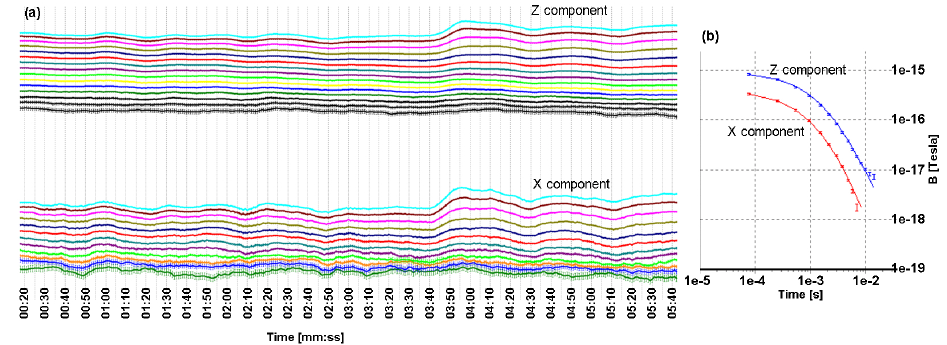
Figure 2. (a) An example of the Z and X components of the B-field data obtained after the application of the moving window stacking with width varying with the time gates. (b) Example of a typical sounding ( Z and X components): the vertical bars represent the stacked data with the associated uncertainty; the solid lines are the calculated data corresponding to the inversion model (not shown).